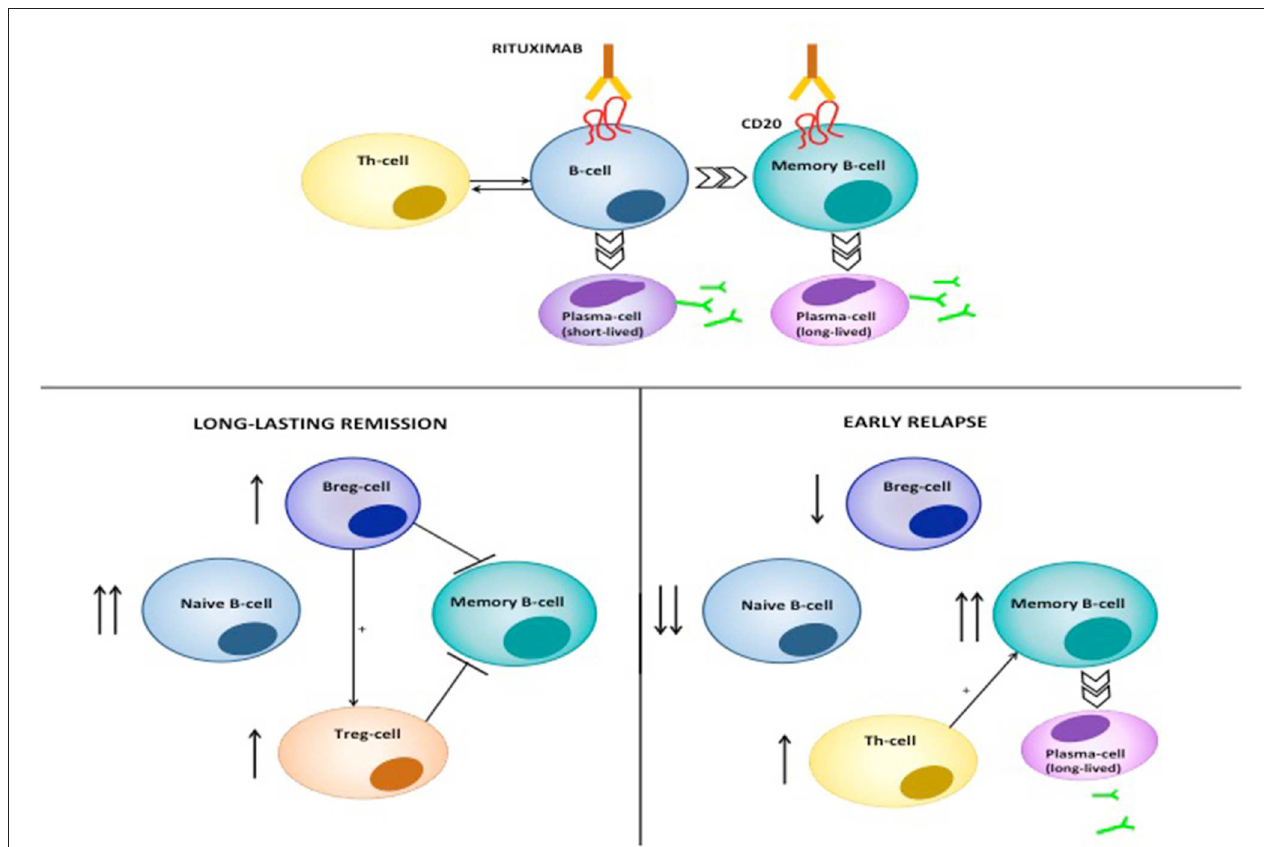
FIGURE 8 | Mode of action of RTX in pemphigus. RTX induces depletion of B-cells and lymphoid resident memory B-cells by different mechanisms, including direct cell apoptosis, complement-dependent cytotoxicity and antibody-dependent cytotoxicity. The latter consists of the phagocytosis of opsonized B-cells by neutrophils, monocytes and macrophages, which express the Fc γ Receptor. Moreover, RTX significantly decreases T-cell function, by depleting antigen presenting B cells. Patients achieving durable responses have an increased naïve/memory B-cell ratio. Regulatory B-cells (B-regs) and regulatory T-cells (T-regs) are also increased, and are inhibitory on Dsg3-specific memory B-cells. On the contrary, patients with early relapses following B-cell repopulation have a decreased naïve/memory B-cell ratio. Reappearance of auto-reactive, Dsg3-specific T-cells contributes to activation of autoreactive B-cells and subsequent anti-Dsg IgG